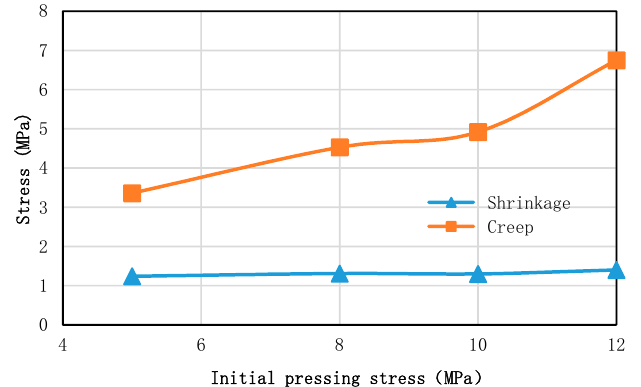
Figure 11. Stress variation in the concrete deck in the hogging region due to different effects for different prestressing stress by tendons. different prestressing stress by